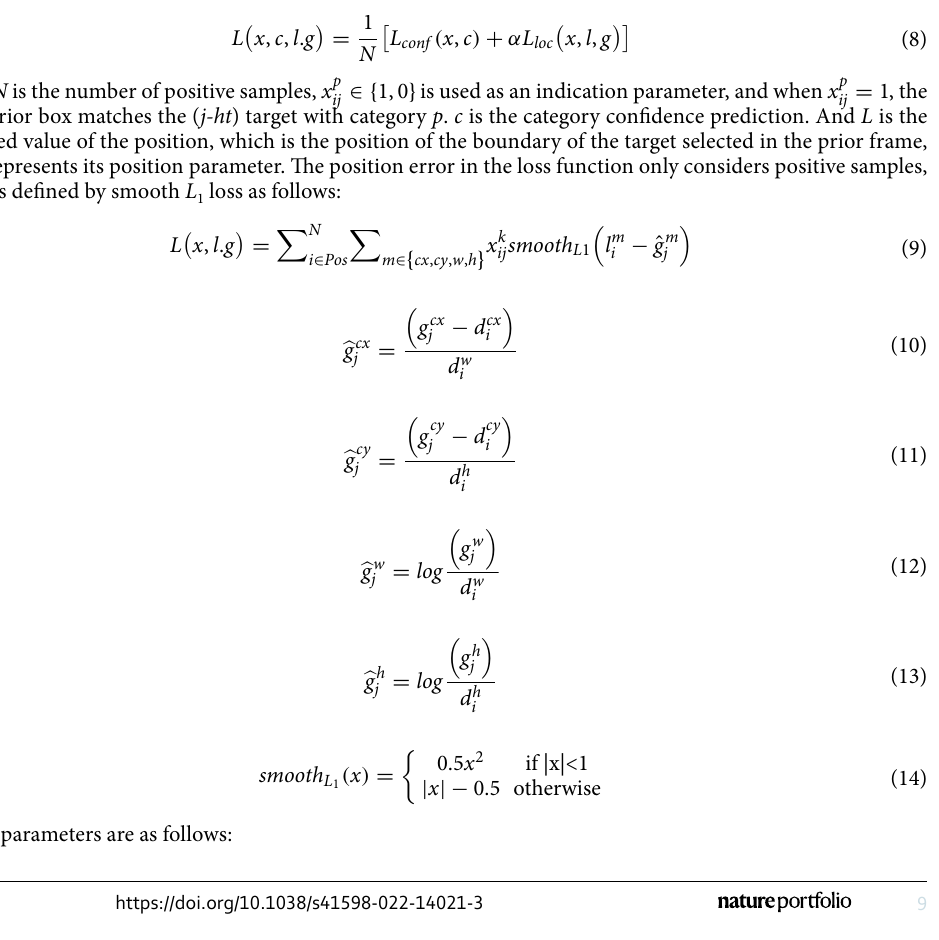
Algorithm training and improvement. Training. Prior box matching. Before work, the prior